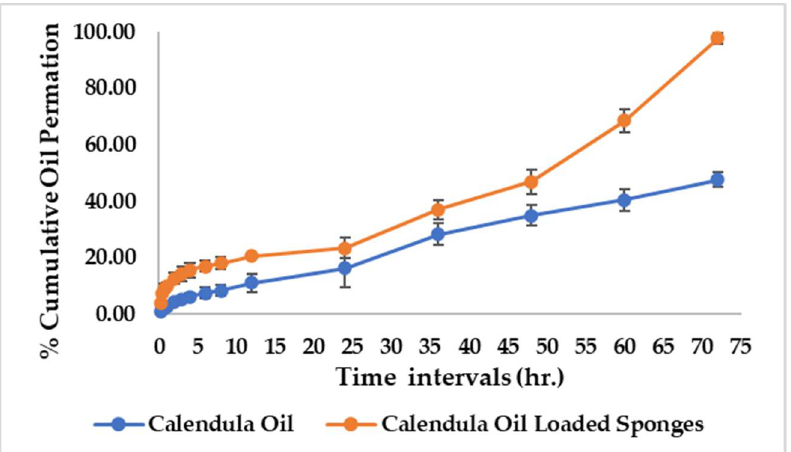
Figure 9. In-vitro diffusion profile of pure Calendula officinalis oil and Calendula officinalis oil-loaded sponge.